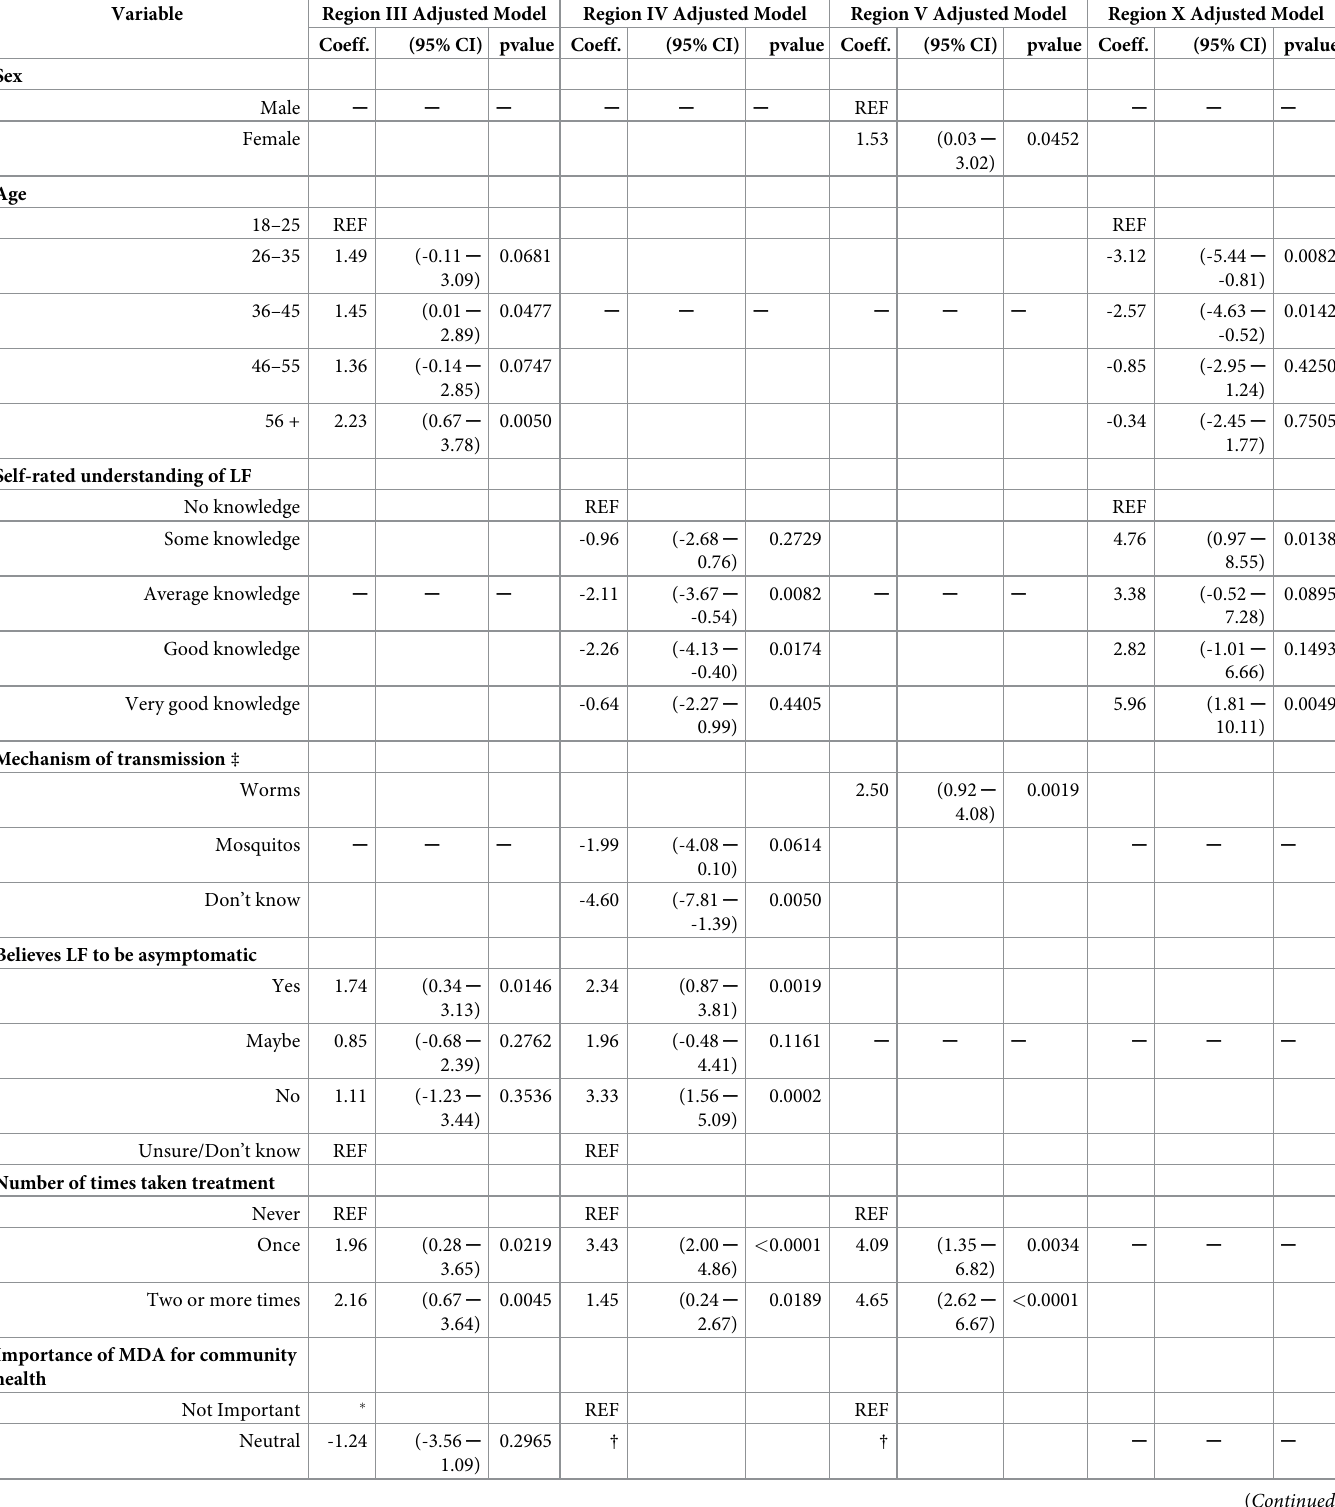
Table 3. Univariable and adjusted linear regression predicting composite acceptability score in regional subsets of the primary study